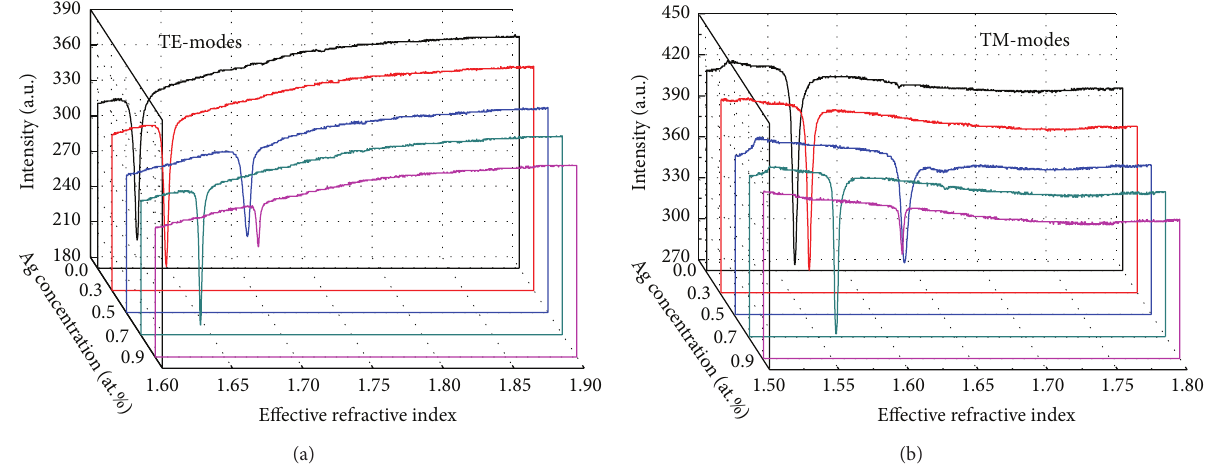
Figure 7: Typical fundamental guided mode spectra of undoped and Ag doped ZnO thin films: (a) TE and (b) TM polarization.